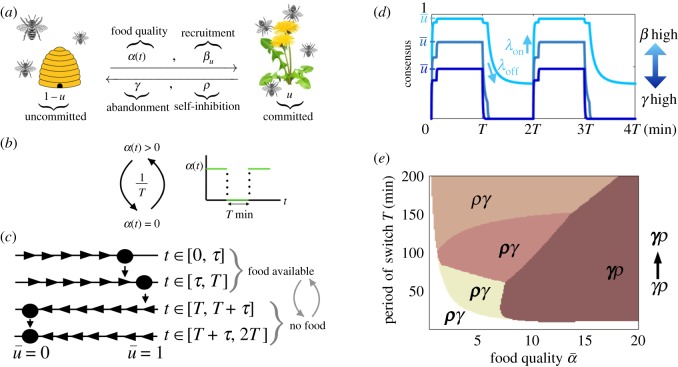
Colony dynamics in the single-feeder model. (a) Schematic of group foraging single feeder, equation (2.3). (b) Food availability α(t) switches on α¯ and off 0 at time intervals T (min). (c) Phase line plots: equilibria of equation (2.3) within each food quality epoch are marked as dots. Dynamic increases/decreases of the foraging fraction are indicated by right/left arrows. Bees forage when food becomes available (α→α¯>0 for t ∈ [0, T)) and u¯>0 is stable and abandon the feeder once food is removed (α → 0 for t ∈ [T, 2T)) if recruitment is weaker than abandonment (β < γ). (d) The fraction of bees foraging u(t) tracks environmental changes. Higher/lower consensus u¯ is obtained by changing the balance of recruitment β and abandonment γ. (e) Reward rate maximizing strategies vary with feeder quality (α¯) and switching interval (T). Each coloured region denotes a different optimal strategy given the environment (α¯,T). The best strategies exclude recruitment (β = 0). Boldness of letters γ and ρ denote the strength of colony behaviours that best adapt to the given environment. In rapid (short T) or low-quality (low α¯) environments (white region), strong inhibition ρ and weak abandonment γ is best, whereas in slow or high-quality environments, inhibition ρ can be weak. We take τ = T/10 min throughout. See appendix A(c) for optimization methods.